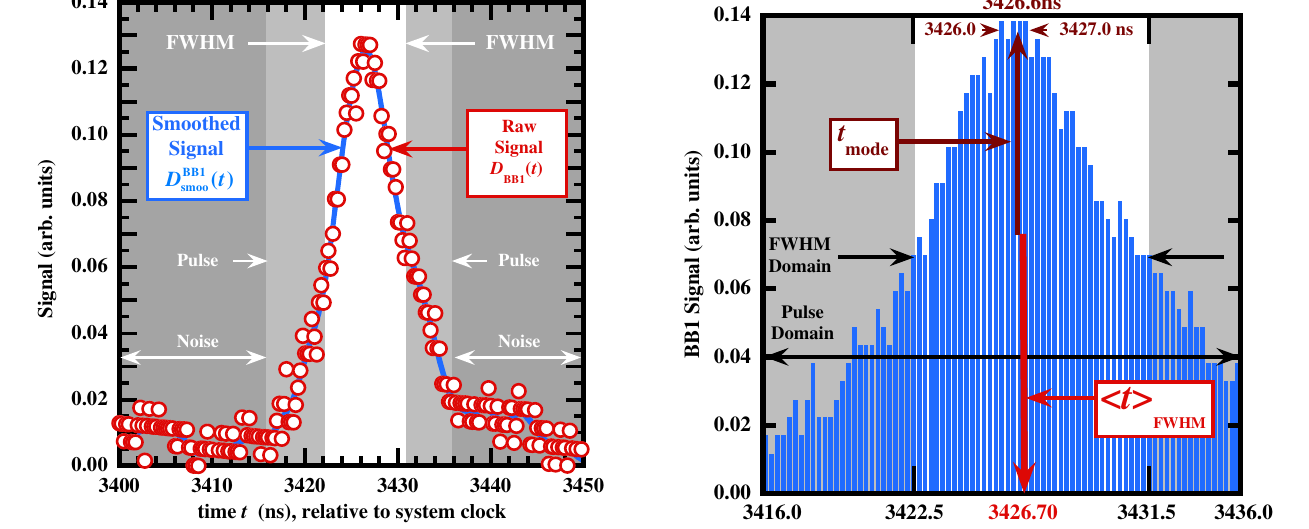
FIG. 11. BB1 portrayed as a pulse-height distribution in the FWHM and pulse domains with corresponding peak measures t and h t i mode FWHM